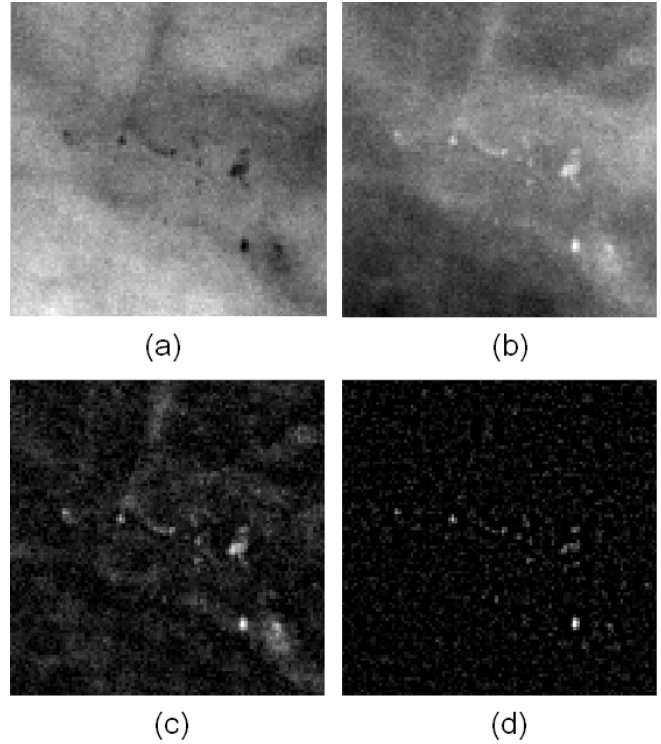
Figure 5. The image before and after transformation and filtering. ( a ) The raw image;